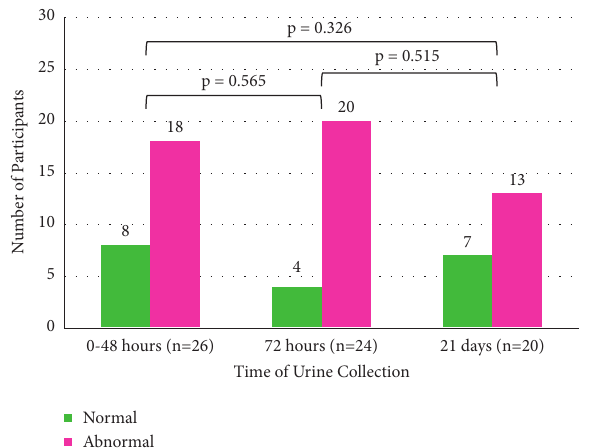
Figure 2: u-LFABP profile across time. Number of abnormal u-LFABP participants was highest at 72 hours. There was no significant difference between u-LFABP levels at each time point (Fisher’s exact test). Table 2: Perinatal factors and insults associated with u-LFABP profiles. u-LFABP